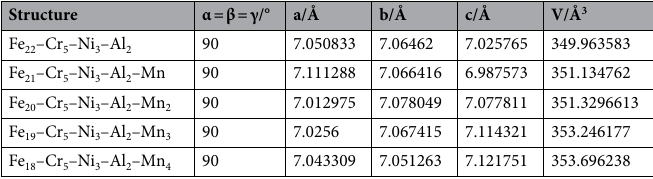
Table 2. Optimized parameters of the five structural